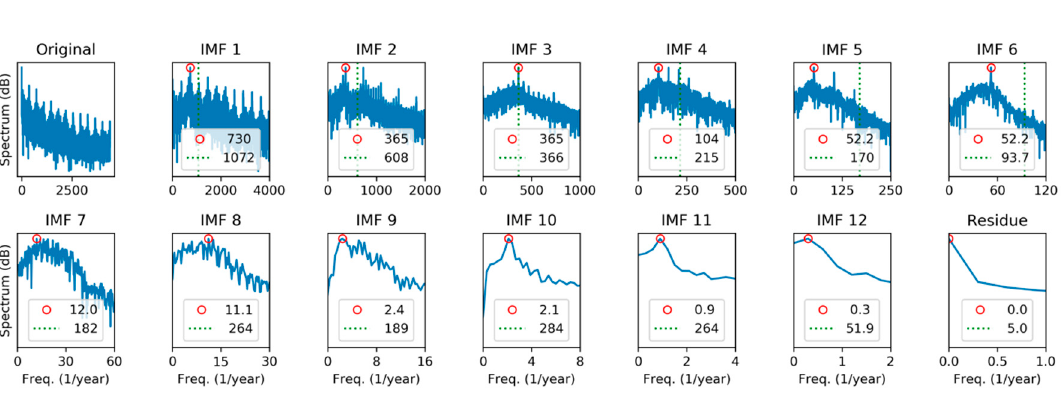
Figure 13. Electricity demand Marginal Hilbert – Huang Spectrum at different frequency scales: ( a ) High; ( b ) medium; ( c ) low. In red are the harmonics obtained by Fourier analysis, while in green are the new harmonics revealed by HHT.